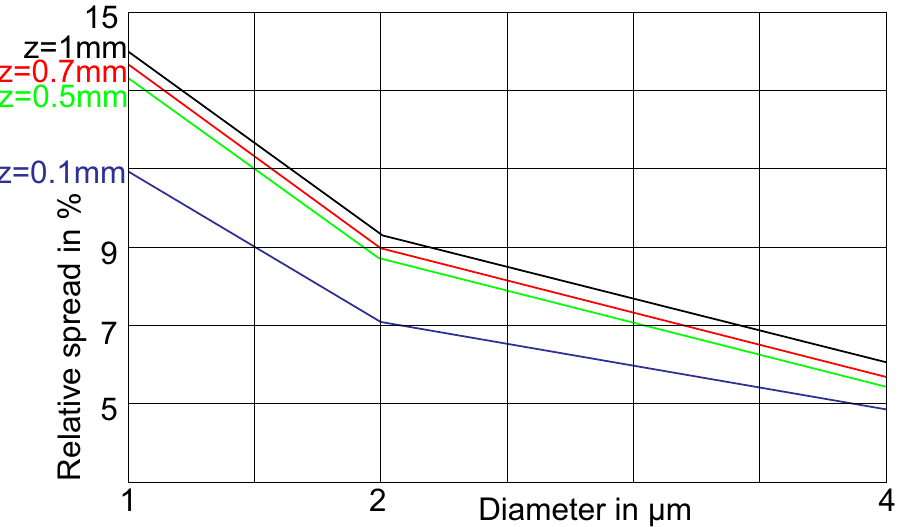
Fig 6. RS as function of axon diameter for different electrode distances z from a myelinated fiber. NoR length 2.1 μ m, internode length 100 � diameter, HH10.